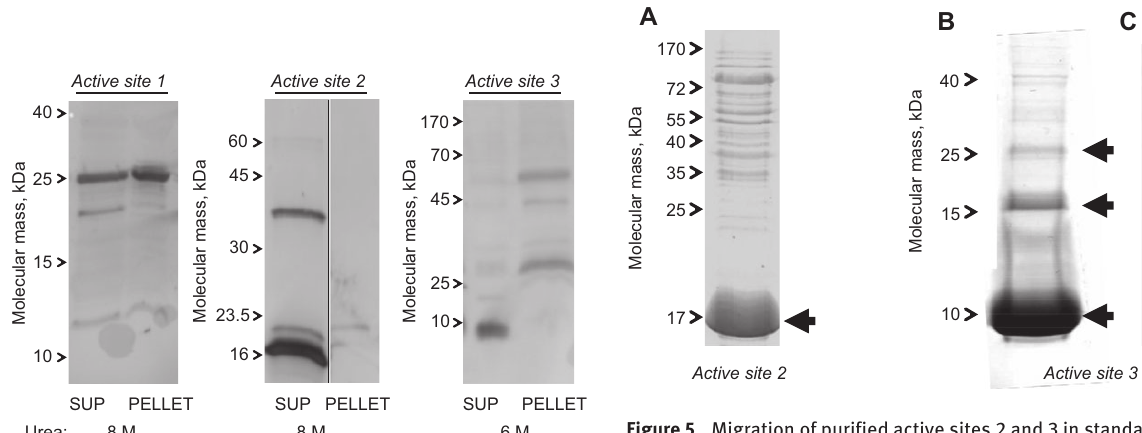
Figure 5 Migration of purified active sites 2 and 3 in standard SDS-PAGE. (A) Analysis of ultrafiltrate of gel filtration of active site 2 by SDS- PAGE and Coomassie staining: 160 μ g protein of active site 2 was separated on a 20% polyacrylamide gel. (B) Analysis of ultrafiltrate of gel filtration of active site 3 by SDS-PAGE and Coomassie stain- ing: 100 μ g protein of active site 3 was separated on a 15% Tris- tricine gel. (C) Western blot of the corresponding active site 3 sample: 2 μ g protein was separated on the same gel as in (B), blotted and the membrane stained with anti-Strep-Tactin horse radish peroxidase antibody conjugate. The full arrows indicate the sites where samples to be analysed by mass spectrometry were taken from. The migration of molecular mass markers is shown by